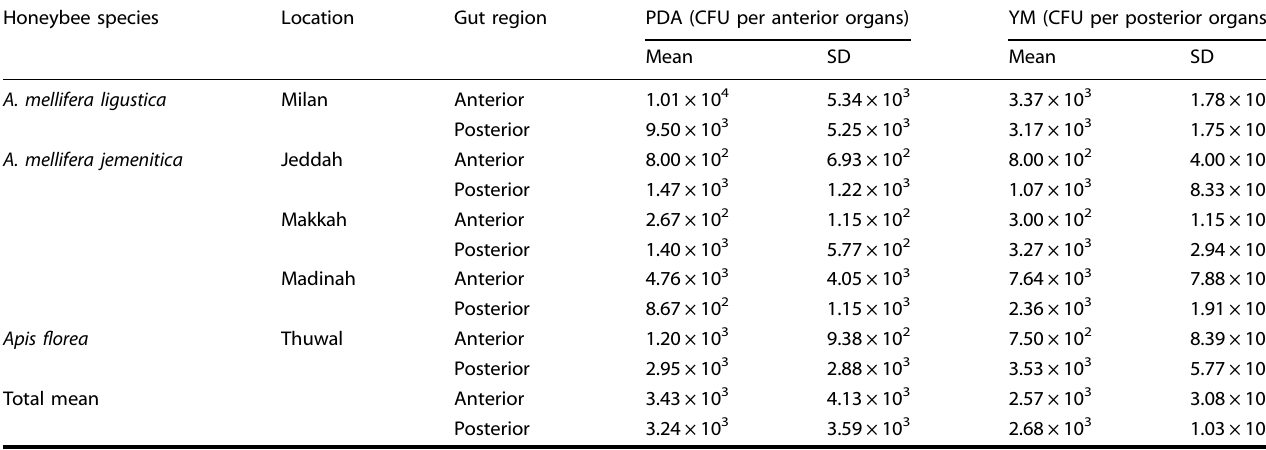
Table 2. Abundance of culturable fungi associated with two gut portions: anterior (i.e., the crop and midgut) and posterior (i.e., the ileum and rectum). Honeybee